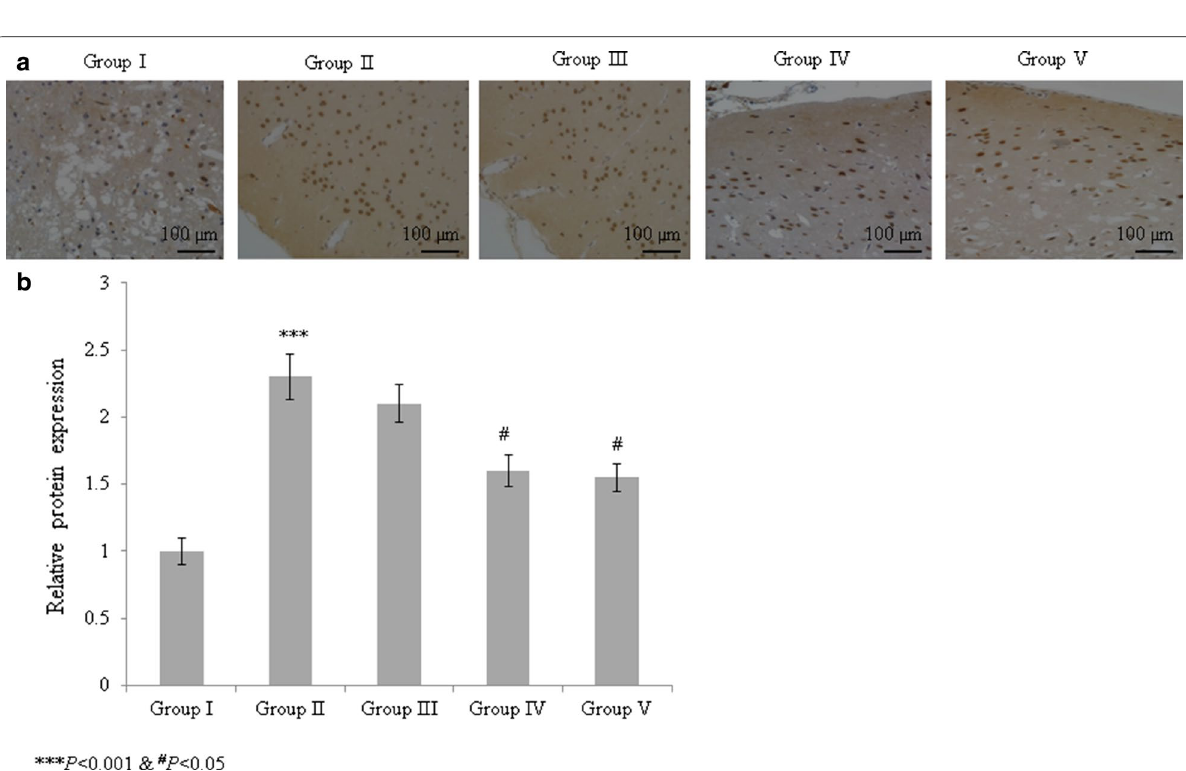
6. Scale bar is 100 =